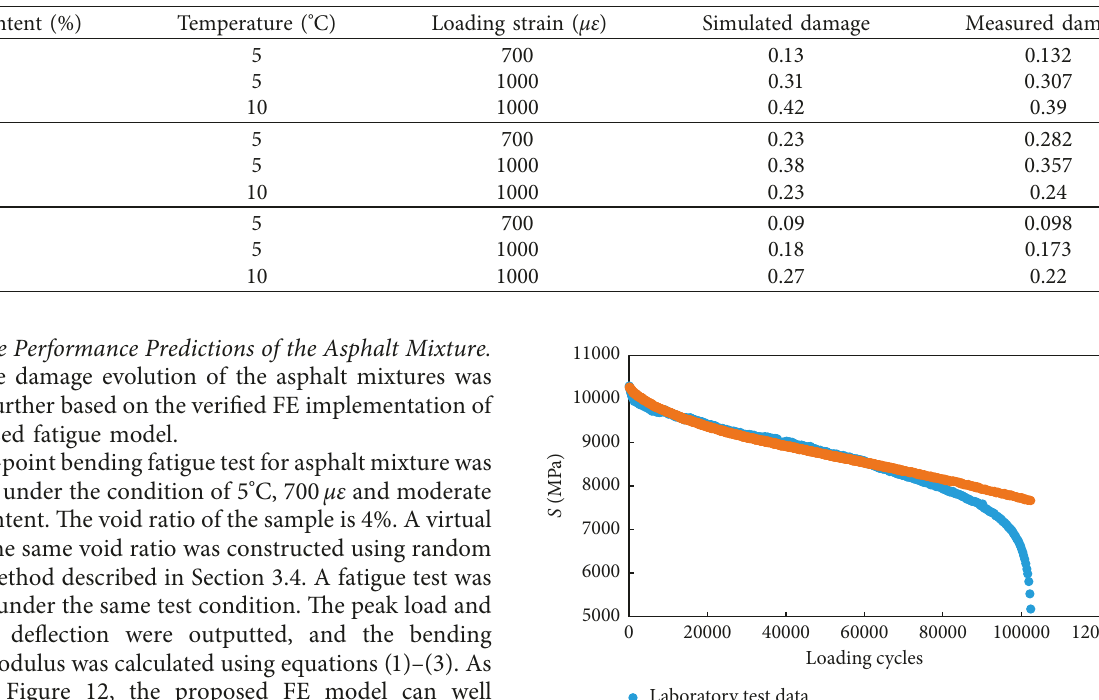
Table 5: Comparison between simulated damage variable and measured damage variable under different test